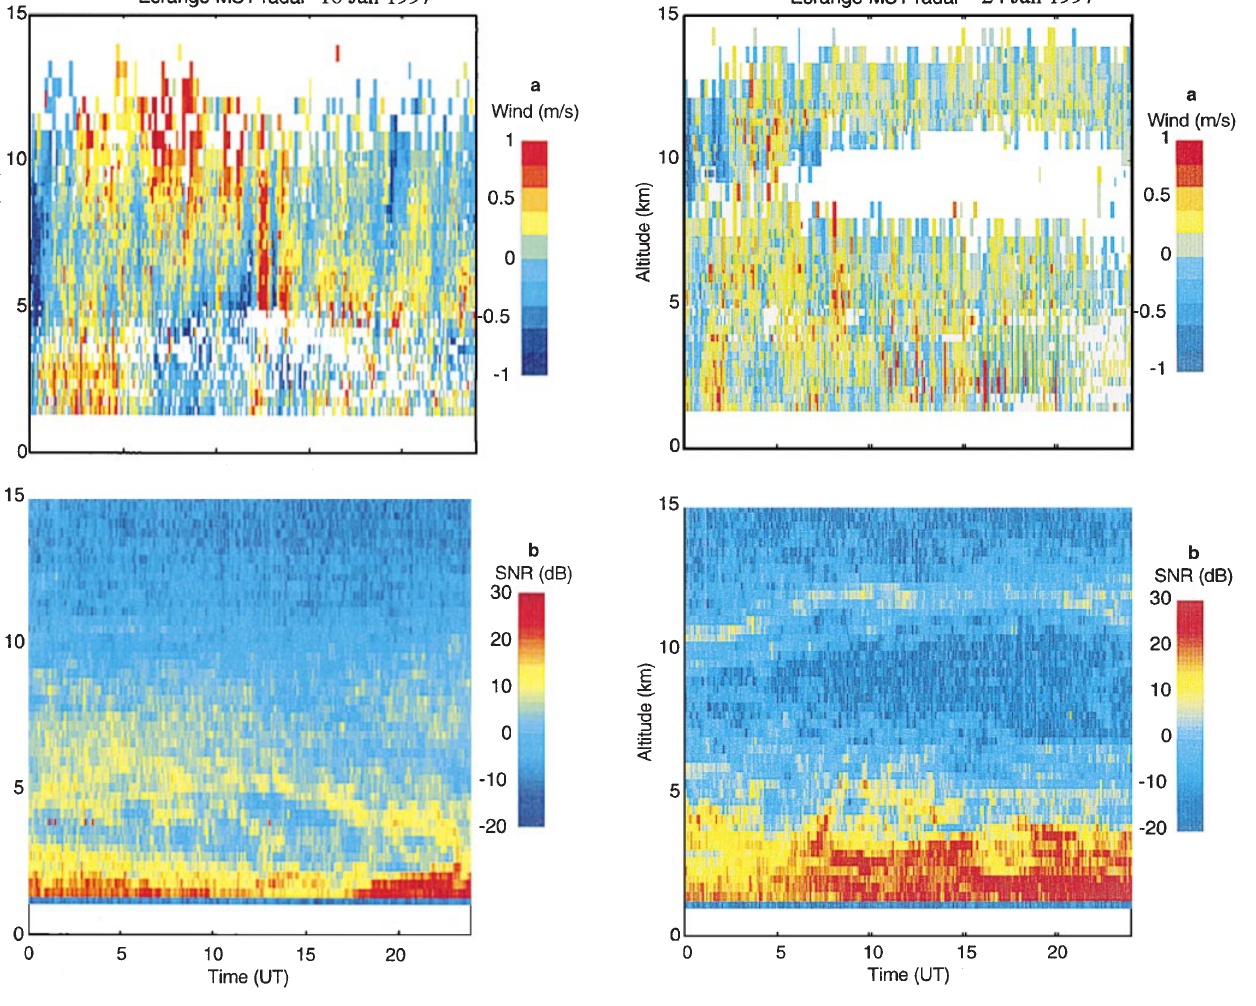
Fig. 2. ESRAD observations of vertical windspeed ( a ) and radar echo strength ( b ) for 10 January 1997